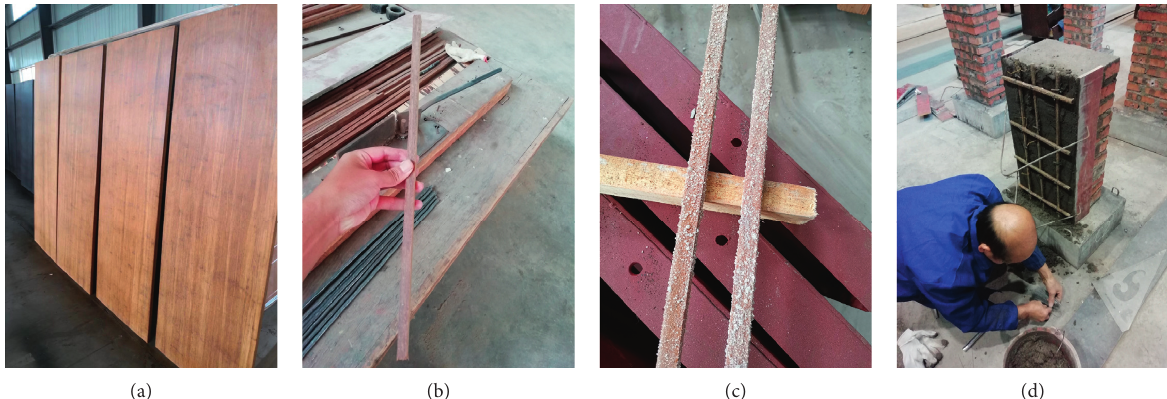
Figure 2: The process of making bamboo scrimber bar: (a) bamboo board, (b) cutting into strips, (c) gluing sand, and (d) binding bamboo